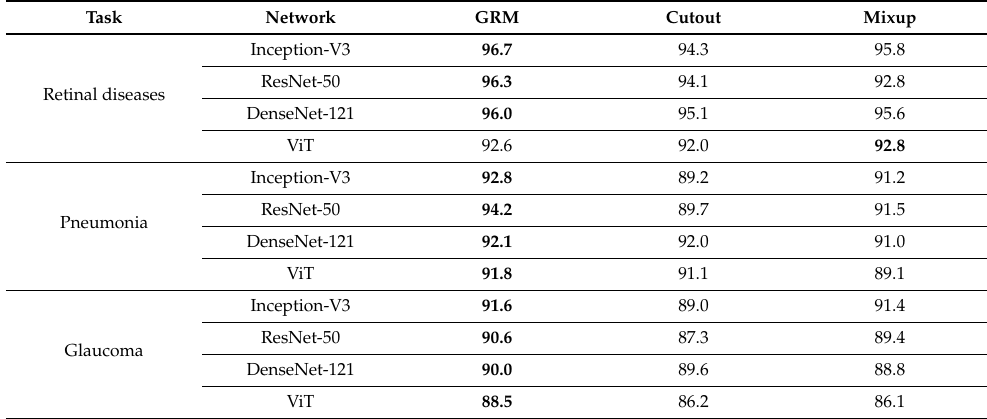
Figure 4. Convergence comparison between the vanilla ResNet-50 and ResNet-50 applied with the proposed GRM on the retinal disease, pneumonia, and glaucoma tasks, respectively. Table 3. Comparison of accuracy (%) between the GRM and related methods on the three medical image analysis